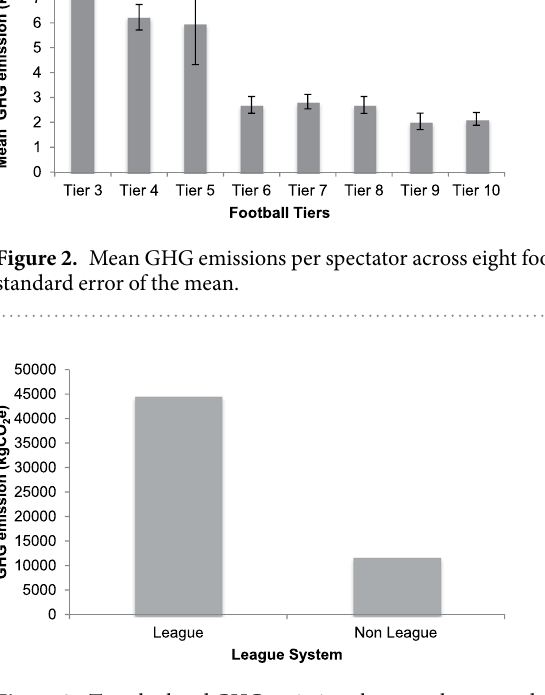
Figure 3. Travel related GHG emissions between league and non-league clubs in